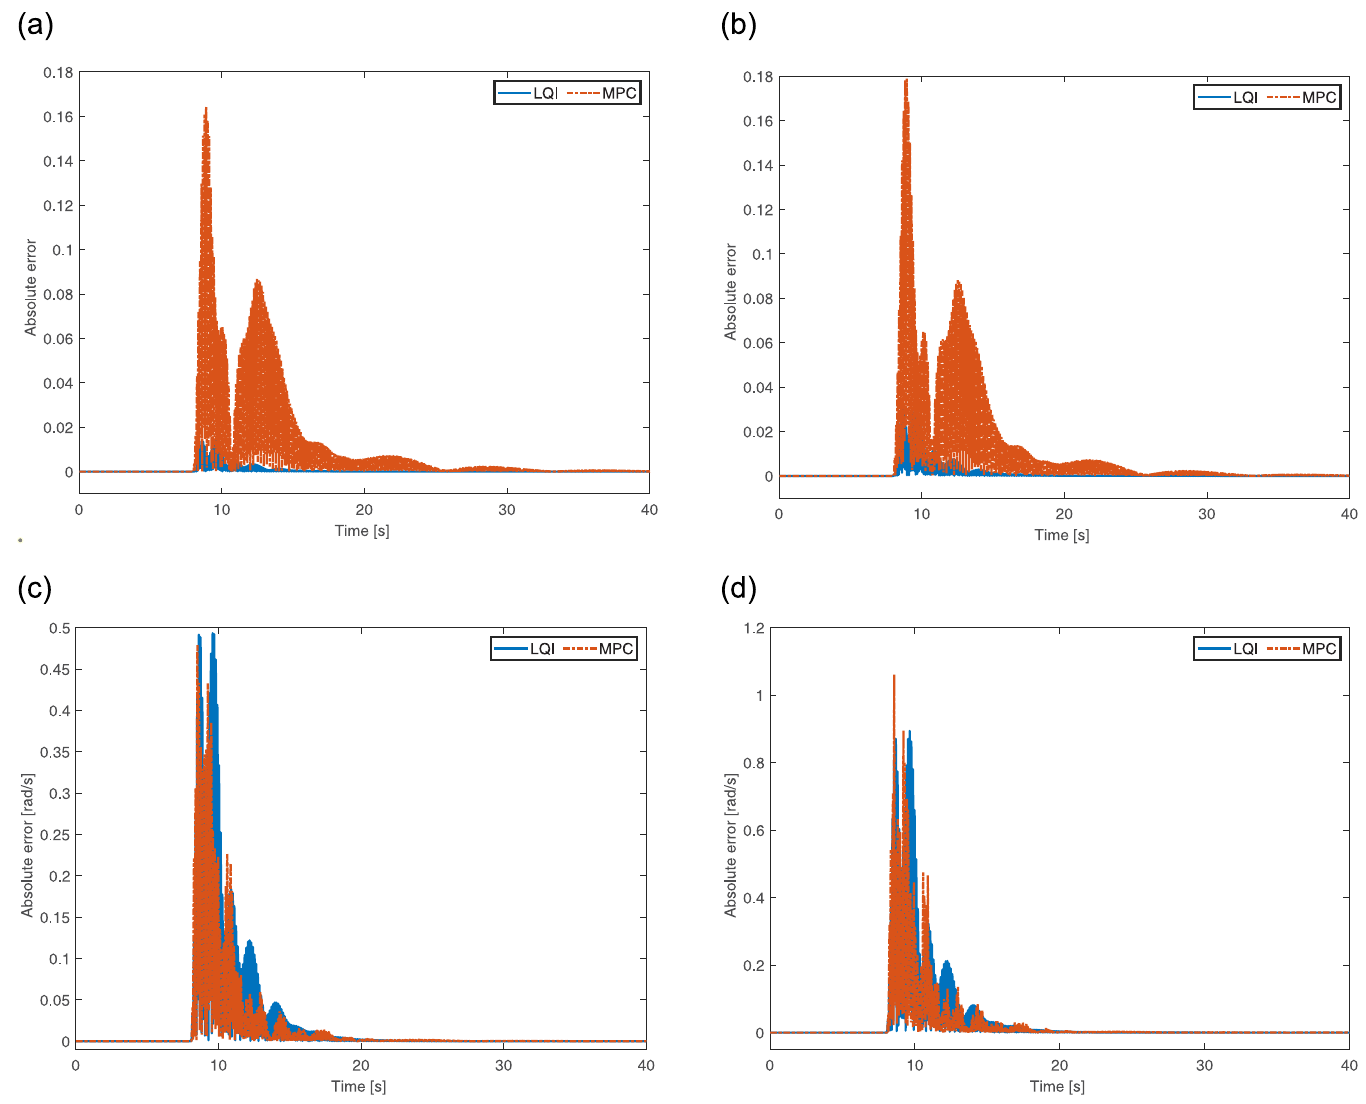
Fig 9. Reduced attitude error of the quadrotor for Two propellers’ failure. (a) Absolute error in primary axis for η Absolute error in angular velocity for p . (d) Absolute error in angular velocity for q